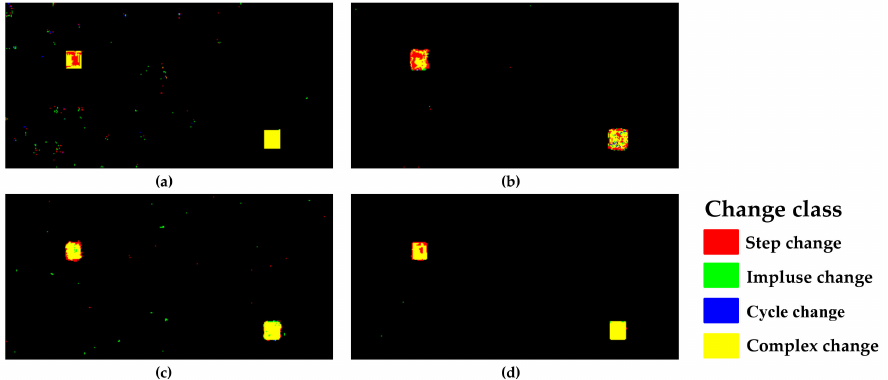
Figure 7. Classification results for complex changes in the white box area: ( a ) NORCAMA; ( b ) NOR_KLD; ( c ) NOR_KS2; ( d ) Proposed